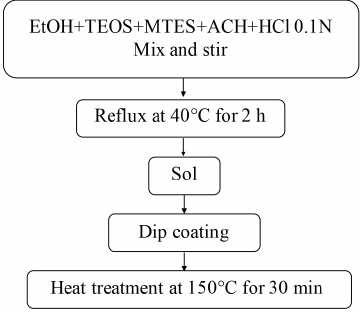
Figure 8. Flow chart of the preparation process SiO 2 layers using MTES and TEOS.